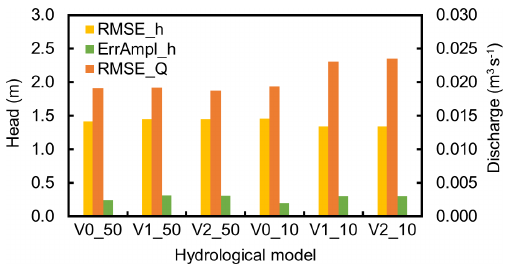
Figure 7. A plot of simulated error statistics based on three met- rics, i.e., root mean squared error (RMSE) of the heads (RMSE_h), RMSE of discharge (RMSE_Q), and error in the yearly groundwa- ter head amplitude